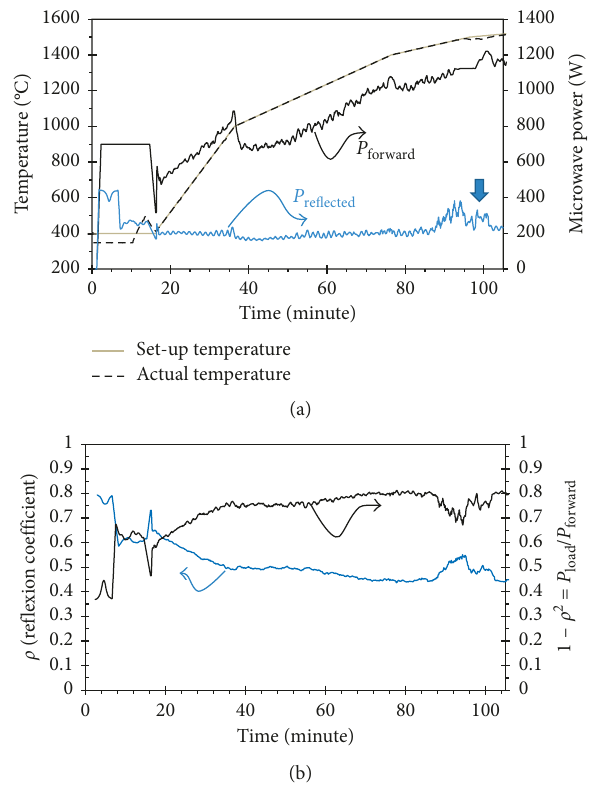
Figure 6: (a) Curves of the set-up and actual temperatures versus time and curves of the forwarded and reflected microwave power versus time during the microwave sintering of MgO-stabilized zirconia. (b) Curves of the reflexion coefficient ( ρ ) and (1 versus time during the microwave sintering of zirconia-based